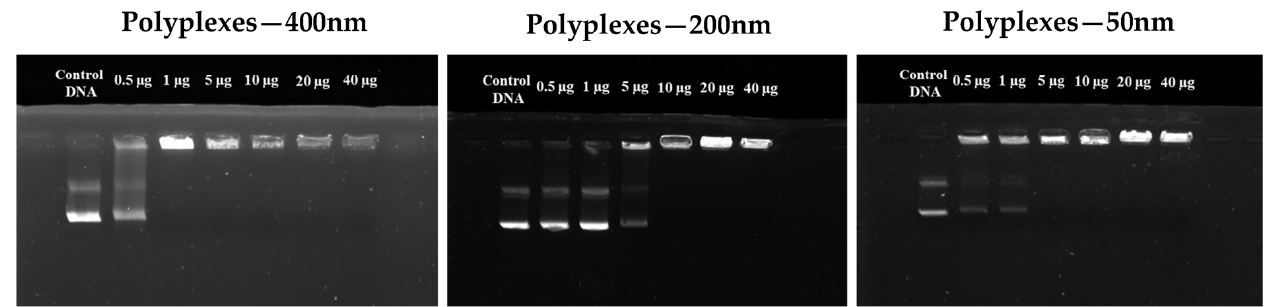
Figure 5. Gel electrophoresis assay with various amounts of reduced NHG’s with GFP plasmid.